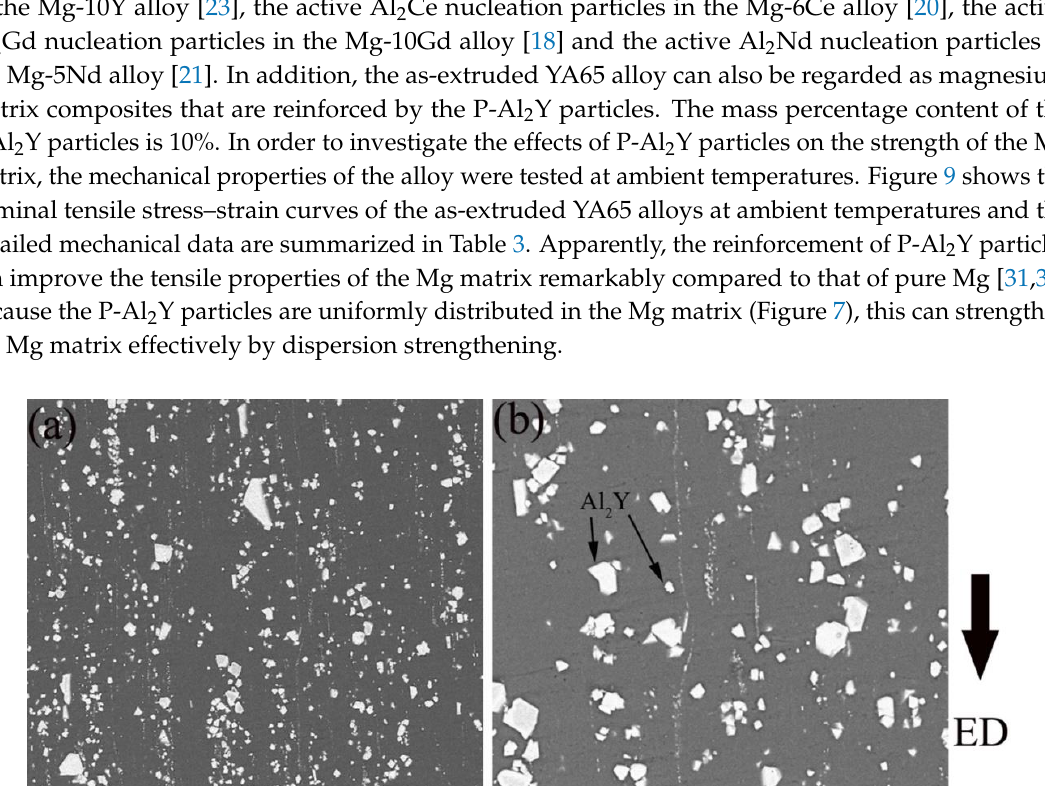
Figure 8. Size distribution of the Al 2 Y particles in the as-extruded YA65 alloy.